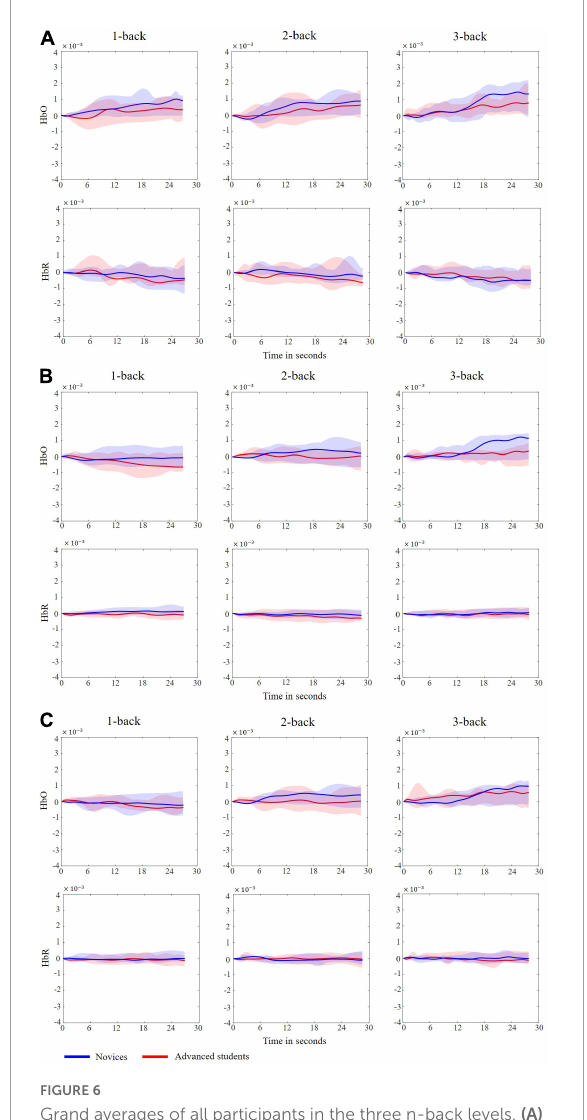
FIGURE6 Grand averages of all participants in the three n-back levels. (A) Left prefrontal cortex. (B) Center prefrontal cortex. (C) Right prefrontal